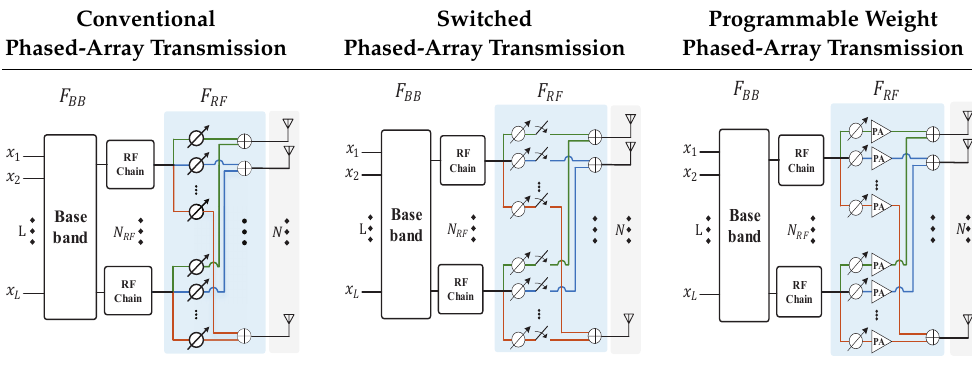
Table 3. The comparison of traditional beamforming scheme and security beamforming